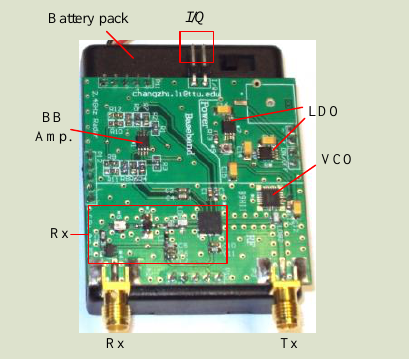
Figure 13. Picture of the 2.4 GHz Doppler radar sensor.